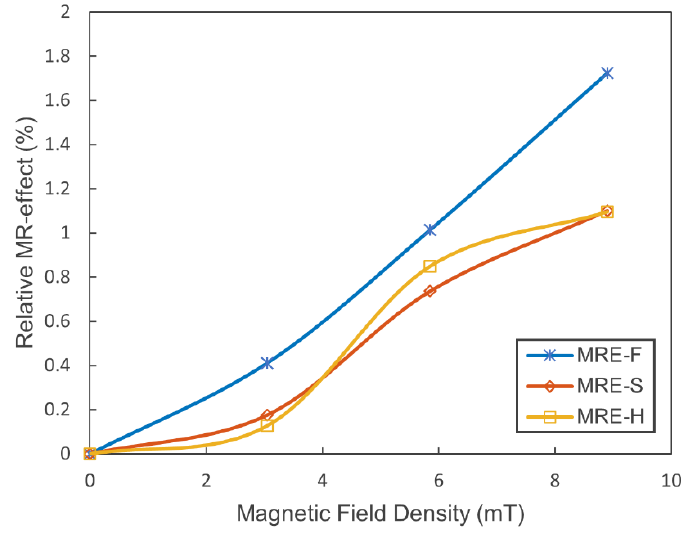
Figure 12. The relative MR-effect of the hybrid MRE samples under different magnetic fields.